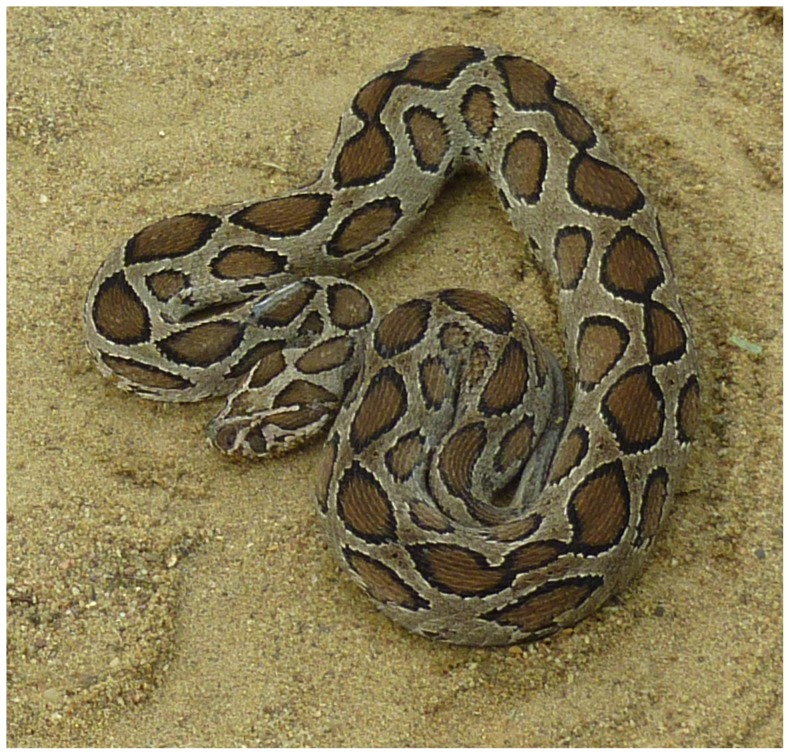
Russell's viper (Daboia russelii) adult specimen from Sri Lanka.Russell's vipers are distributed throughout Sri Lanka except at higher elevations (>1500 m) and are abundant in agricultural lands in the rural areas of the island's dry zone.